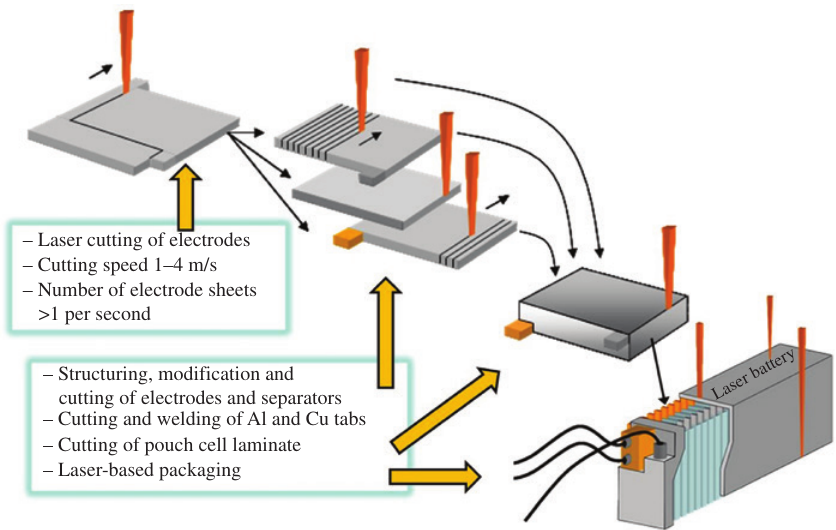
Figure 1: Laser-supported production steps for manufacturing of lithium-ion cells in pouch cell